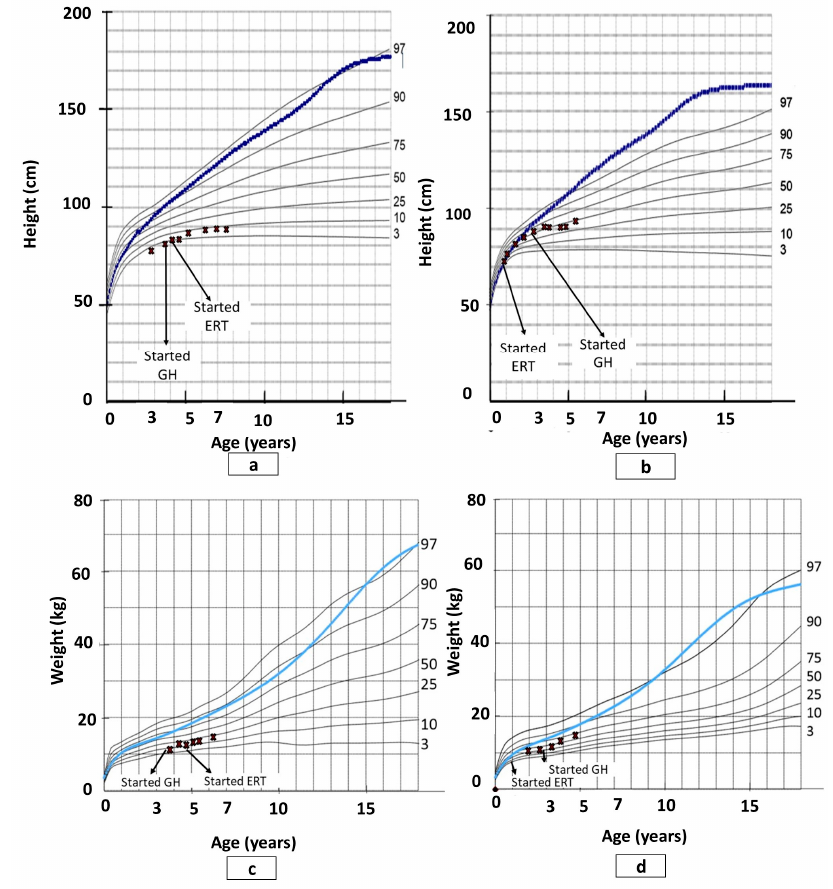
Figure 1. Growth charts of males and females with mucopolysaccharidosis IVA (MPS IVA) and study participants: ( a ) patient 1 height; ( b ) patient 2 height; ( c ) patient 1 weight; ( d ) patient 2 weight. Note: ERT, enzyme replacement therapy; GH, growth hormone; the dotted and blue lines show the 50th percentile values for normal males and females; the Xs show study participants; revised from Montaño et al. [32].